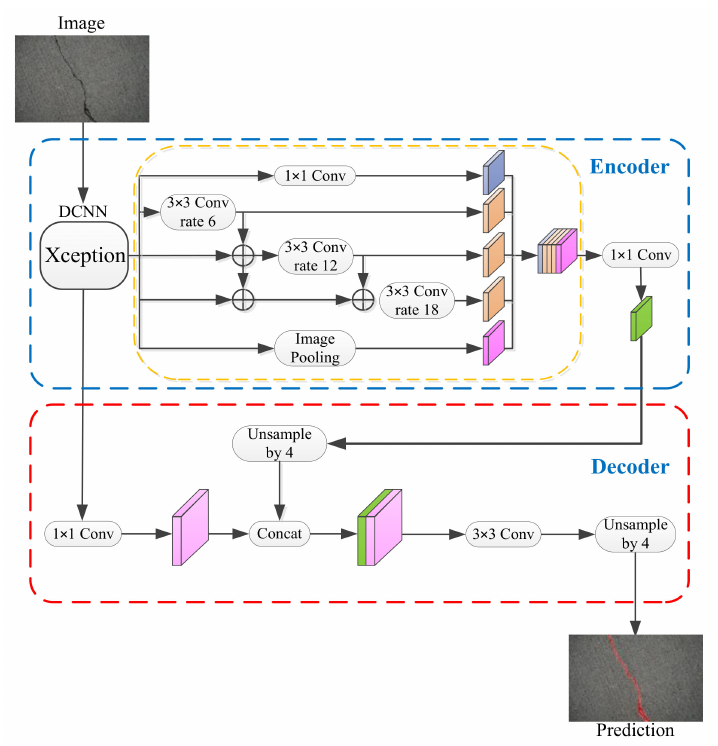
Figure 4. Dense-DeepLabv3+ network structure.